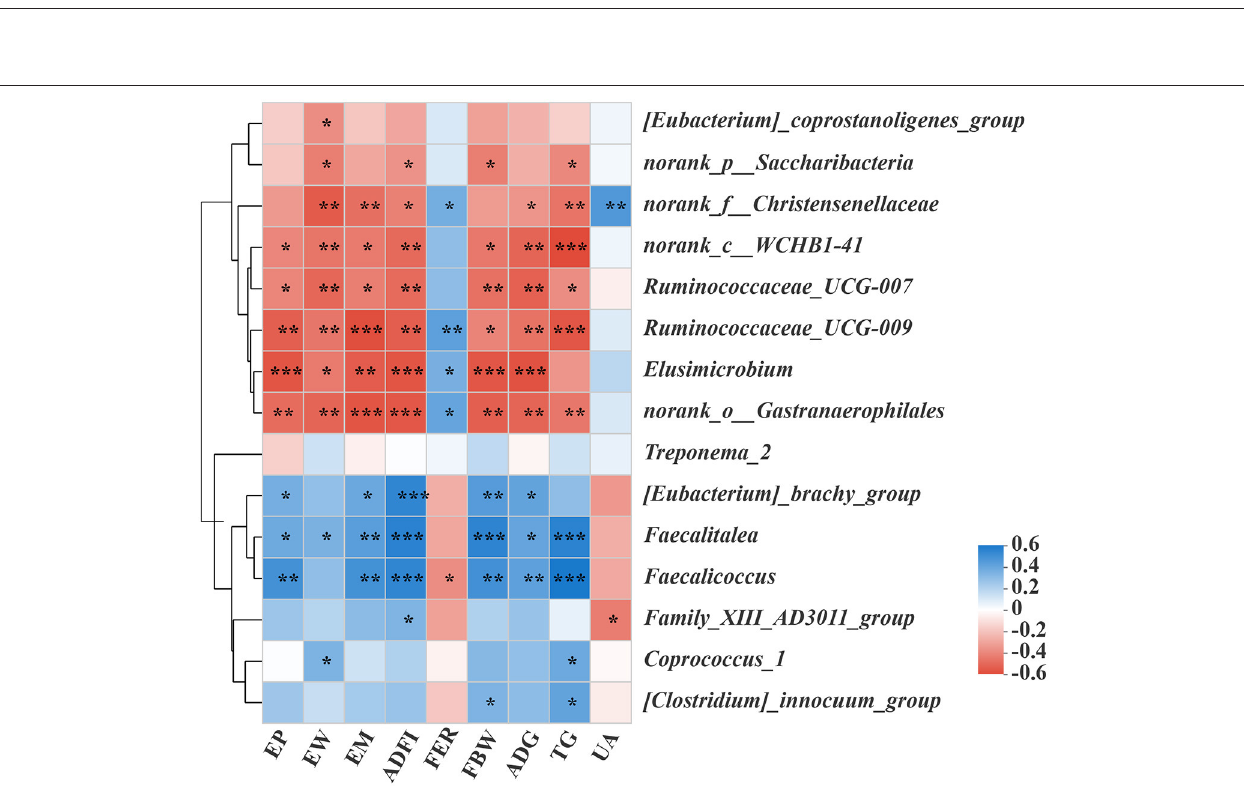
FIGURE 5 | The effects of different dietary Met supplementation in low protein diets on the difference of the gut microbiota and its correlation with the phenotype of laying hens. The correlation between the various gut microbiota and the phenotype of laying hens. Asterisks indicate significant correlations (* p ≤ 0.05, ** p ≤ 0.01, *** p ≤ 0.001). The blue represents a significantly positive correlation ( p ≤ 0.05), the red represents a significantly negative correlation ( p ≤ 0.05), and the white represents no significant correlation ( p > 0.05).